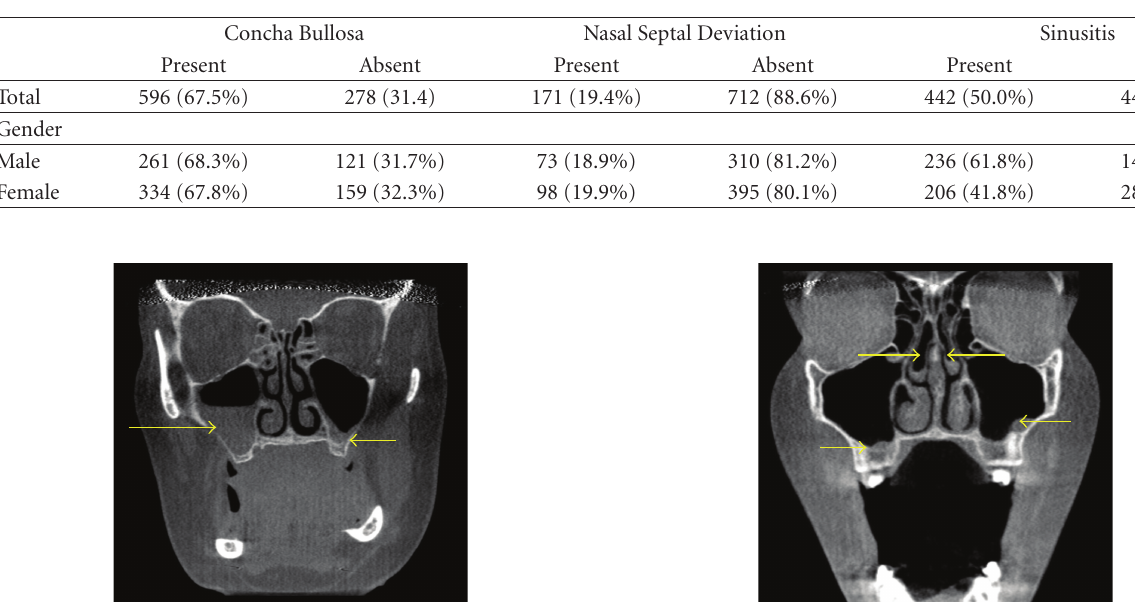
Table 2: Prevalence and gender distribution of concha bullosa, nasal septal deviation, and sinusitis.